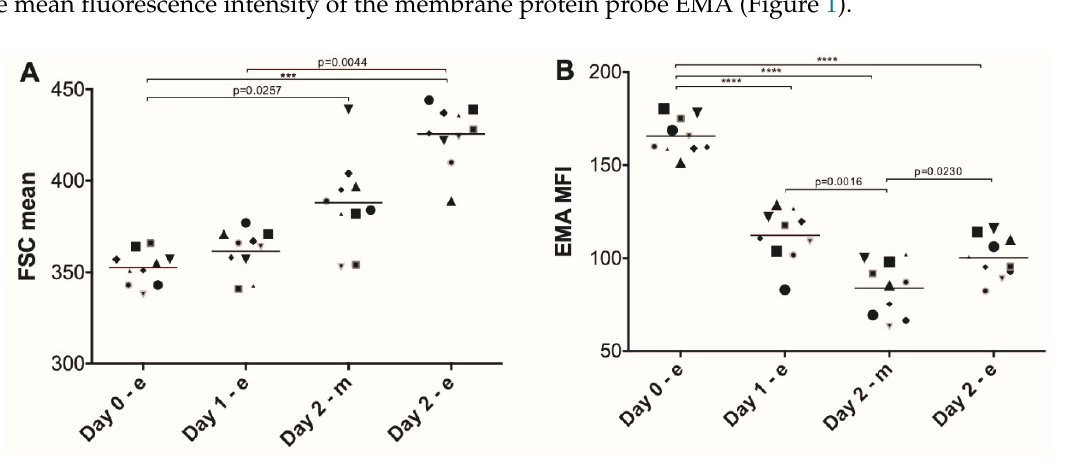
Figure 1. Changes in forward scatter and eosin-5’ maleimide (EMA) binding of red blood cells during the Nijmegen Four Days Marches. ( A ) Mean forward scatter (FSC) extracted from the flow cytometry data; ( B ) the mean fluorescent intensity (MFI) after binding of EMA, as described in Materials and Methods. Each symbol represents one donor. Significant differences: ***, p < 0.001; ****, p < 0.0001 (N = 10).